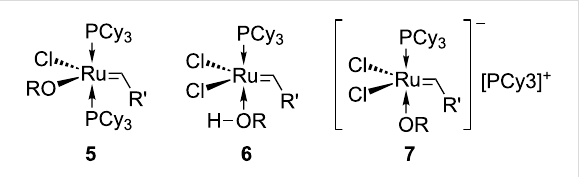
Figure 1: Allylic hydroxy activation in RCM [19].